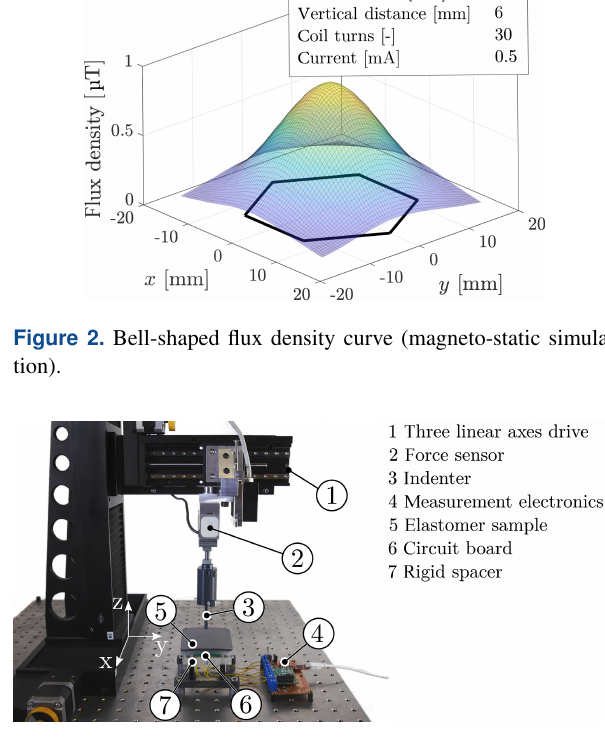
Table 1. Experimental